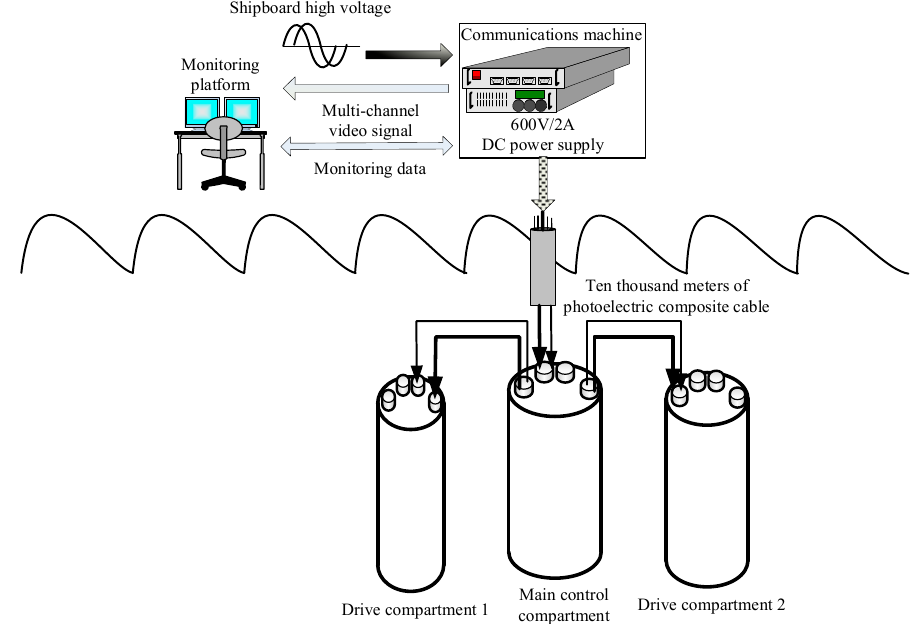
Figure 9. Sampling monitoring system structure diagram.